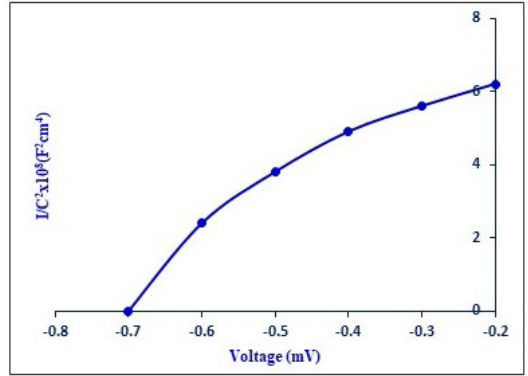
Zn Se photoelectrode. 0.5 0.5